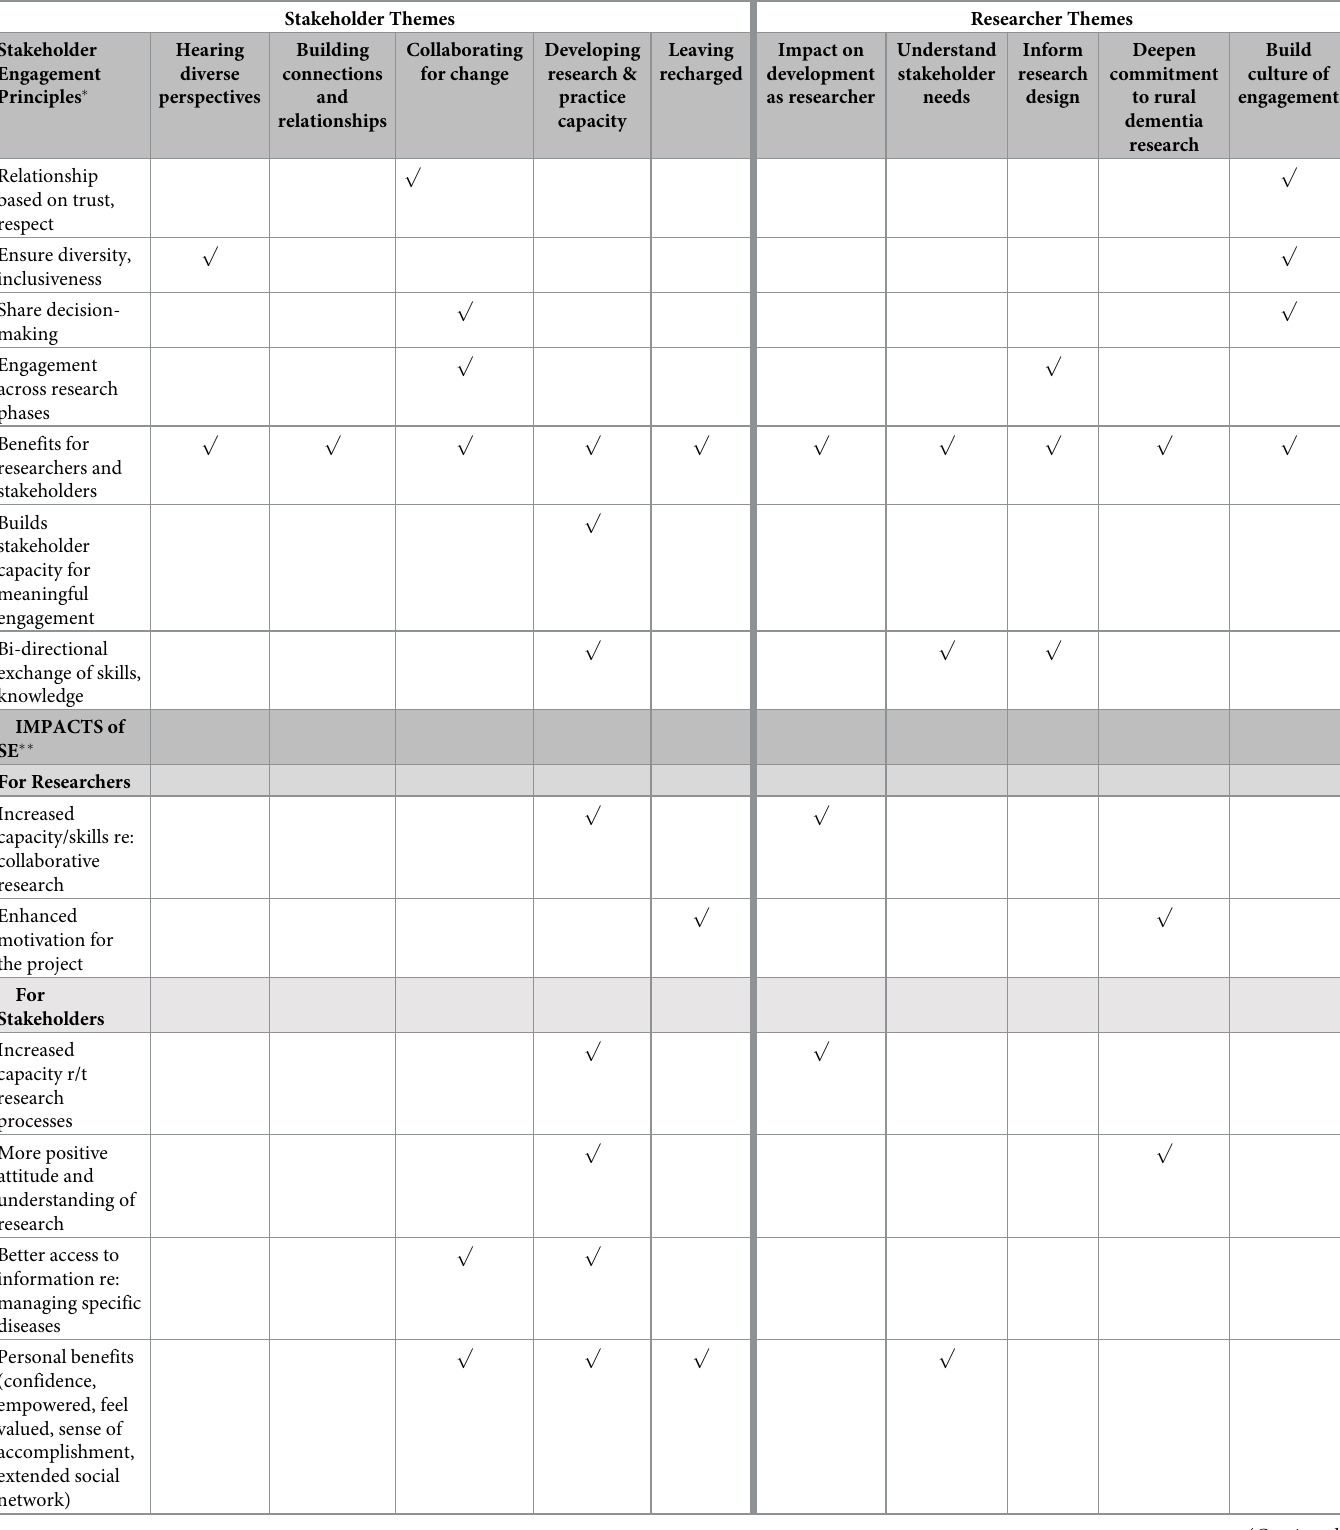
Table 3. Alignment of stakeholder and researcher themes with published stakeholder engagement principles and